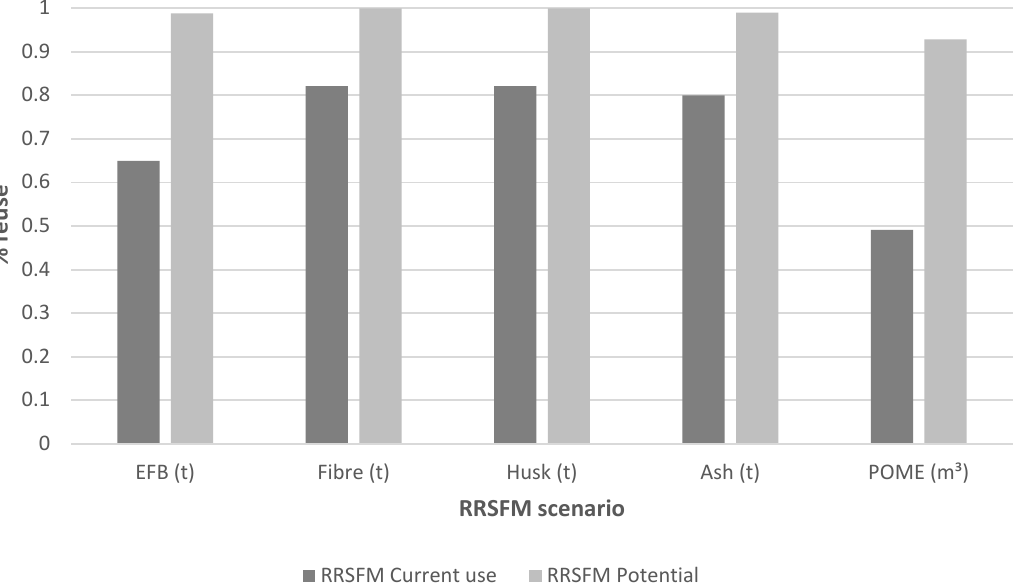
Figure 4. Percentage or degree of the current use of palm oil residues and by-products in the agro- industries in the Casanare Department.